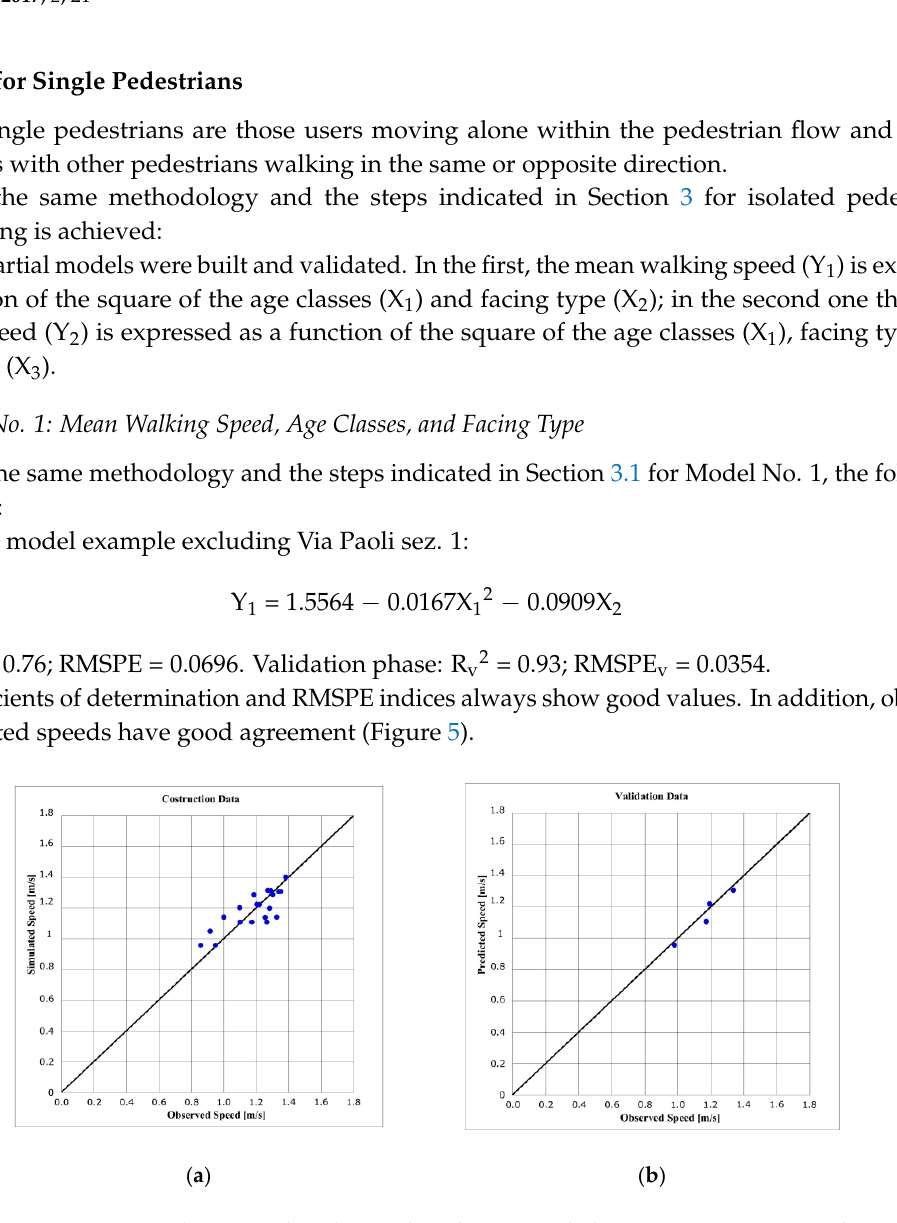
Figure 4. Global model. Comparison between observed and simulated speeds.